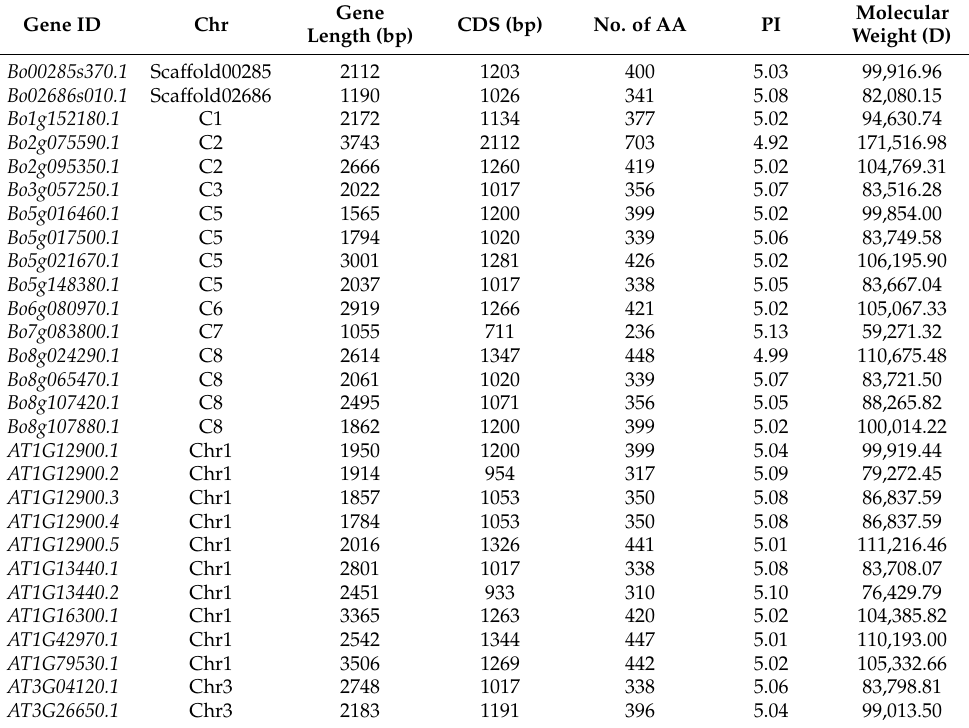
Table 1. GAPDH gene information in B. oleracea and A. thaliana